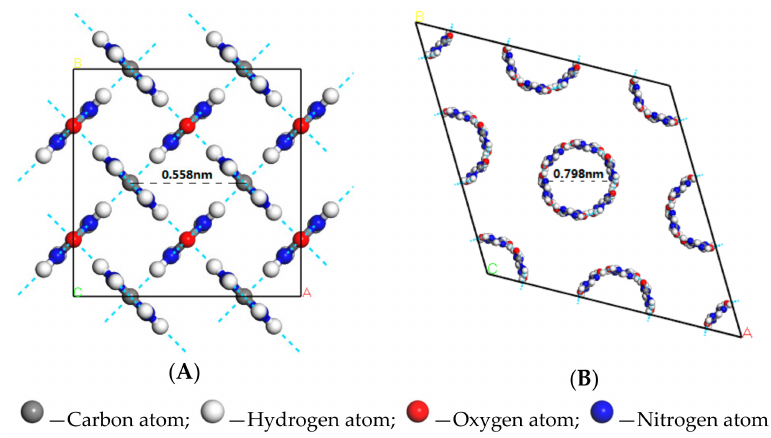
Figure 4. Tetragonal crystal structure ( A ) and hexagonal crystal structure ( B ) of urea.